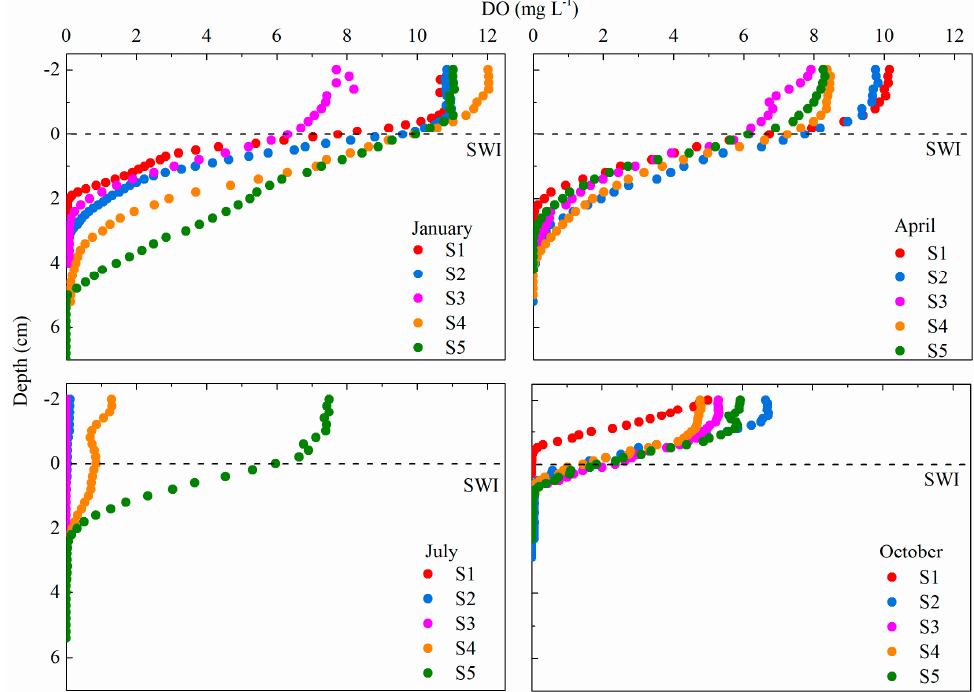
Figure 2. Dissolved oxygen (DO) profiles distributed across the sediment–water interface (SWI) during the field investigation period.